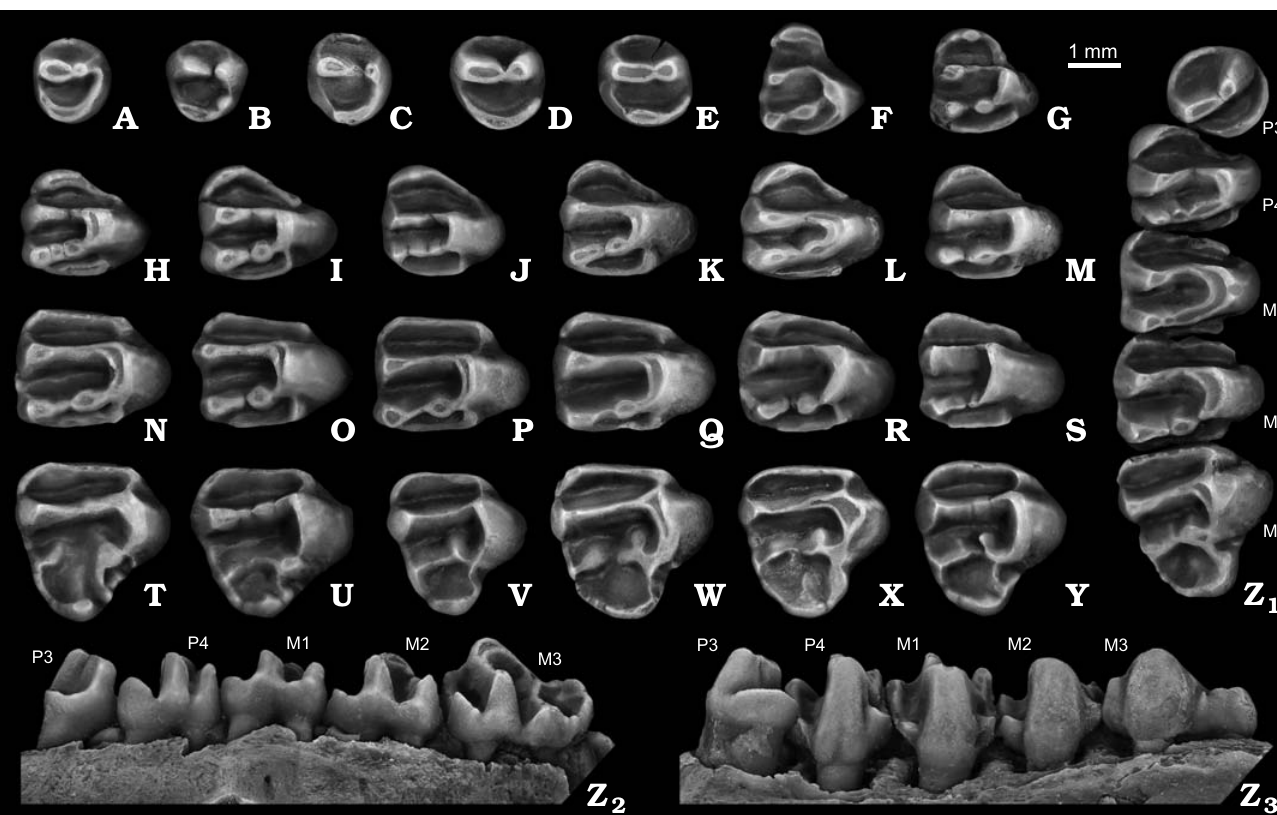
Fig. 3. Ground squirrel Spermophilus nogaici (Topachevsky, 1957) from the Early and Middle Pleistocene of southern Ukraine and southwestern Russia: Tarkhankut (A, B, G, H, I, O, U), Zhevakhova Gora 1 (F, N, T), Nogaisk (C, J, K, P, V, W, X), Moiseevo 1 (Q), Tihonovka 1 (D, L, R, S, Y, Z), Bol- she vik 2,I (M); upper cheek teeth (A–E, P3; F, G, DP4; H–M, P4; N–S, M1–M2; T–Y, M3; Z, P3–M3), in occlusal (A–Z 1 ), labial (Z 2 ), and lingual (Z 3 ) views. A . NMNHU-P 50-29/10. B . NMNHU-P 50-29/11. C . NMNHU-P 27-230. D . NMNHU-P 29-212. E . NMNHU-P Bol2/1-4. F . NMNHU-P ZG1-1. G . NMNHU-P 50-29/69. H . NMNHU-P 50-29/25. I . NMNHU-P 50-29/27. J . NMNHU-P 27-123. K . NMNHU-P 27-239. L . NMNHU-P